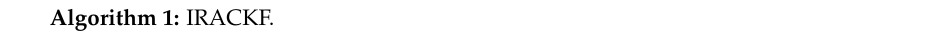
Algorithm 1: IRACKF.